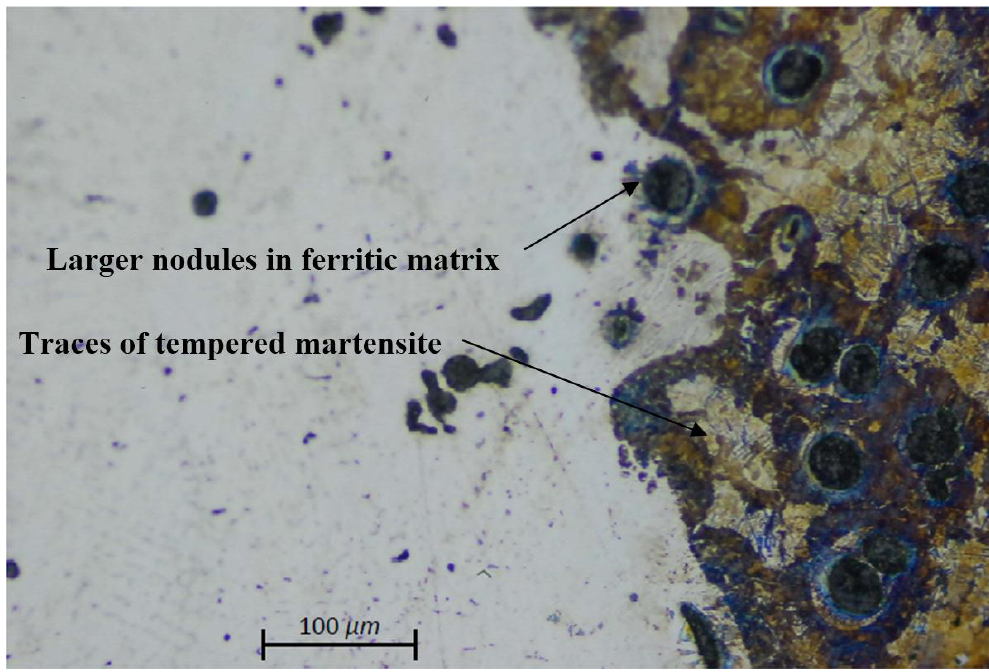
Figure 3. Micrograph of a weld performed with a 97.6% Ni electrode on a ductile iron casting with heat treatment at 350° C and air cooling.